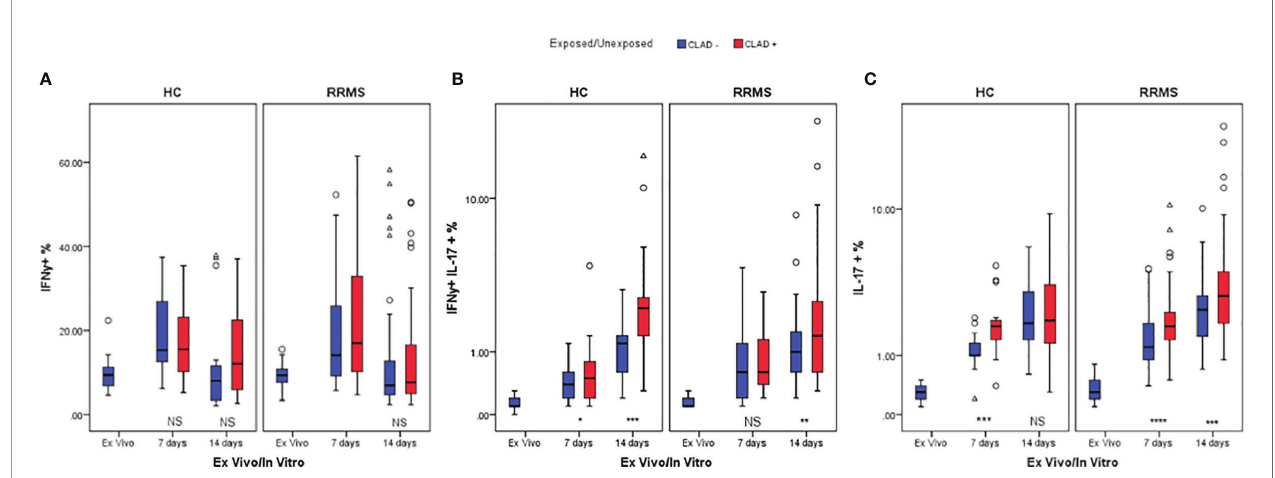
FIGURE 9 | HC and RRMS CD3+IFN g + (A) , CD3+IFN g +IL17+ (B) , and CD3+IL17+ (C) cell percentages changes with cladribine treatment at day 7 and 14 represented as boxplot (median with error bars). NS, non signi fi cant (p > 0.05) P -values were considered signi fi cant when lower than 0.05 (* p ≤ 0.05, ** p ≤ 0.01, *** p ≤ 0.005, **** p ≤ forHCatday7and14,butincreasedsigni fi cantlyforRRMSatboth time points ( p =0.027 at day 7 and p =0.007 at day 14) ( Figure 10B ).